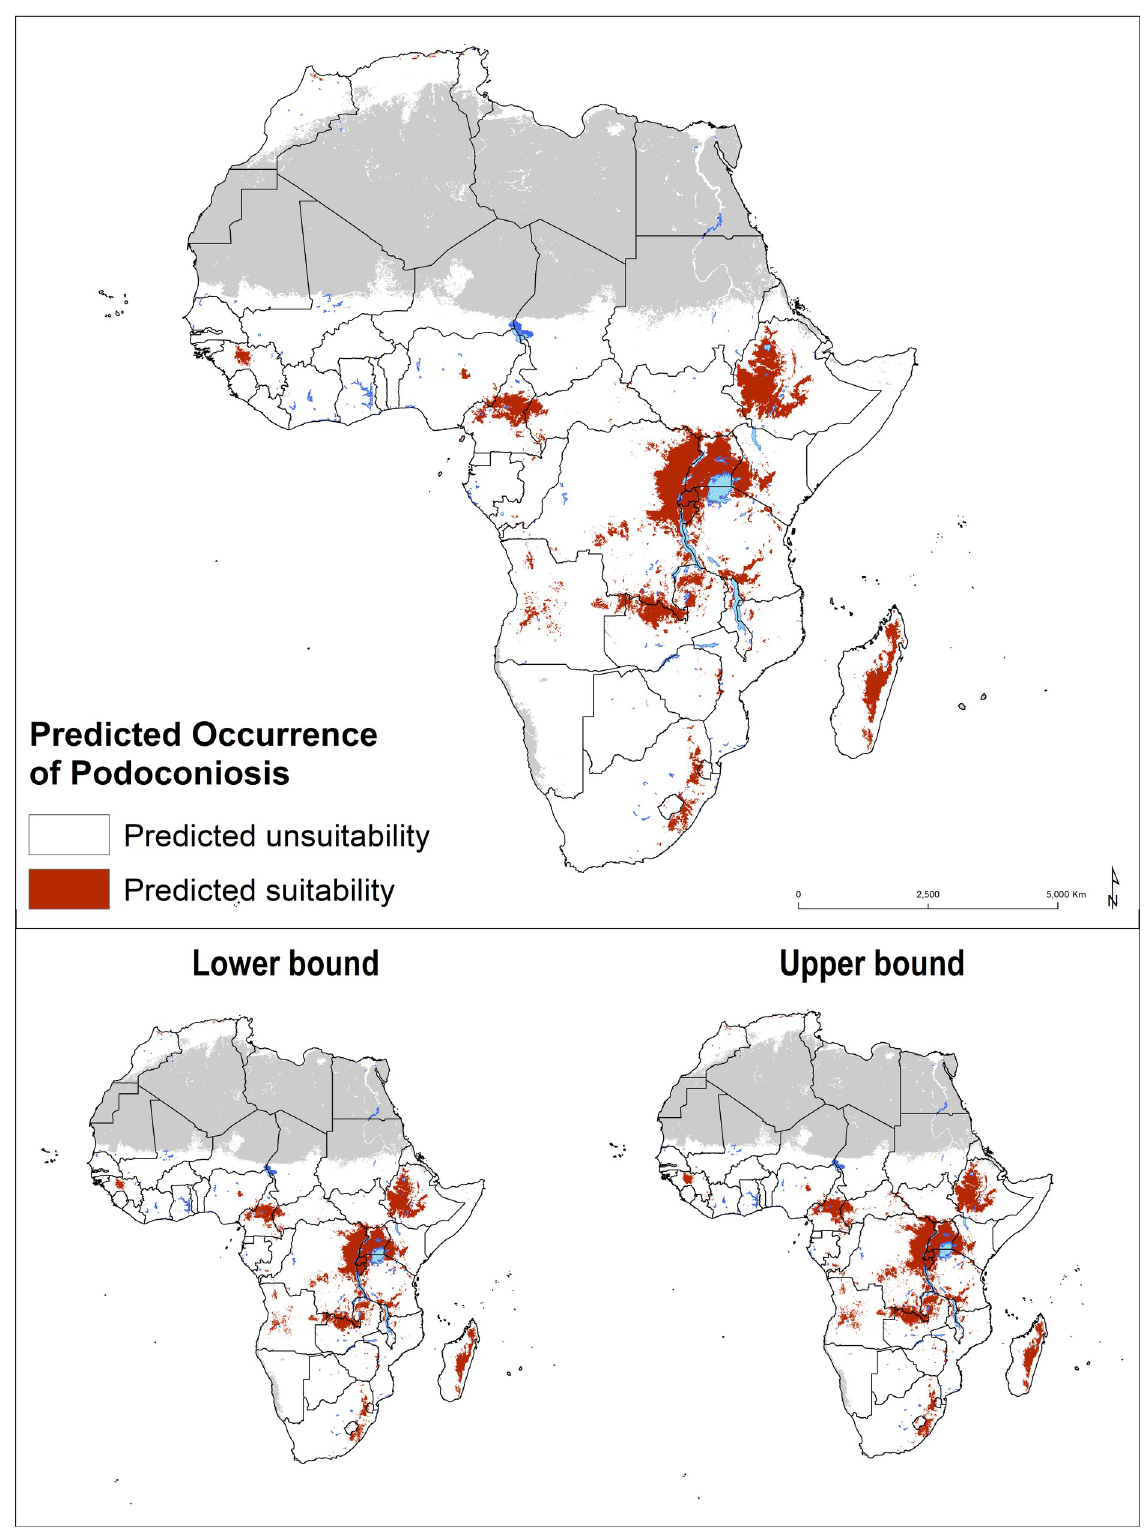
Fig 3. Predicted occurrence of podoconiosis in Africa with the lower (2.5%) and upper (97.5%) bounds of the occurrence limits based on the optimal threshold of environmental suitability (0.389).